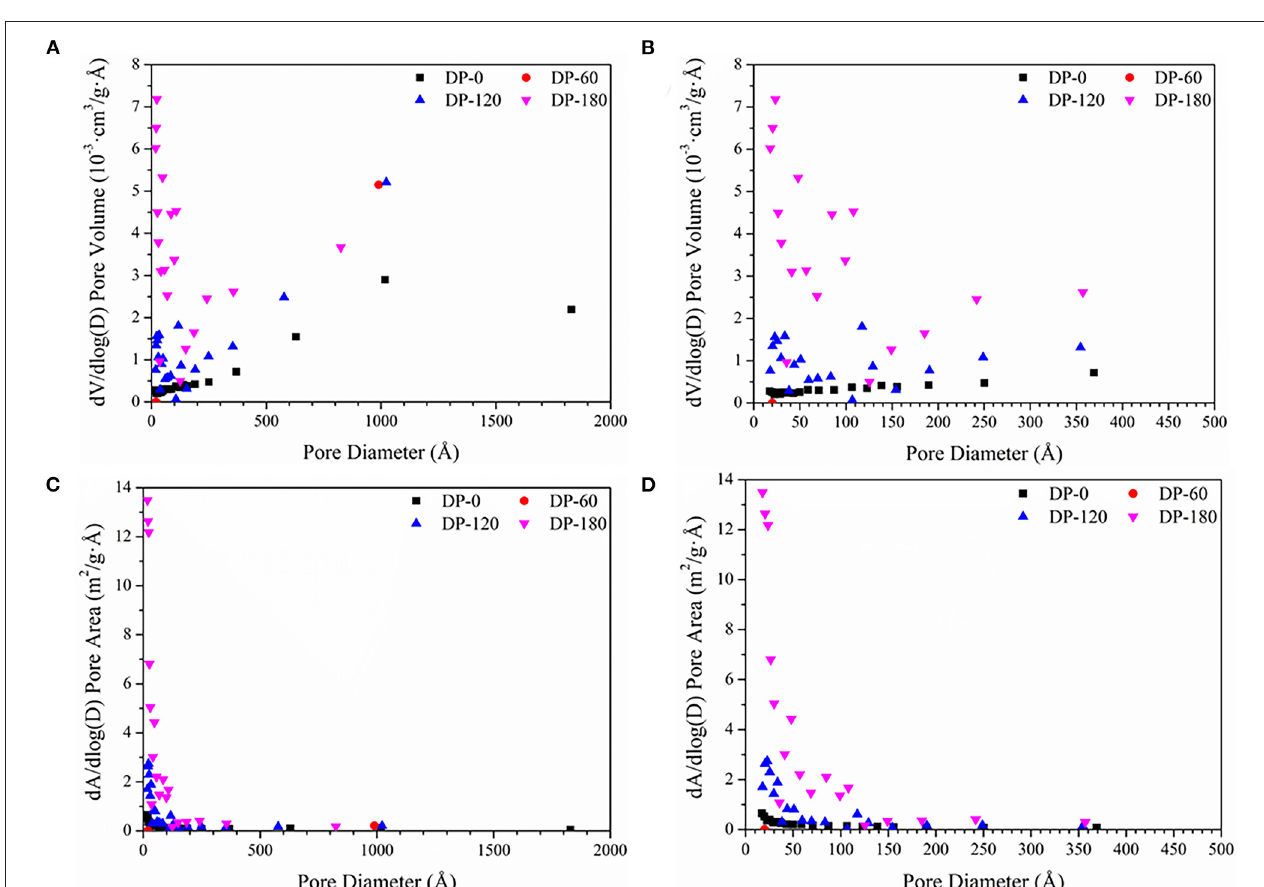
FIGURE 4 | Distribution of pore diameter as functions with dV/dlog(D) pore volume (A,B) and dA/dlog(D) pore area (C,D) respectively. (A,C) are the pore diameter distribution in the full range of 0–2000 Å (Å = 0.1nm), while (B,D) are the pore diameter distribution of mesopores (0–500 Å).